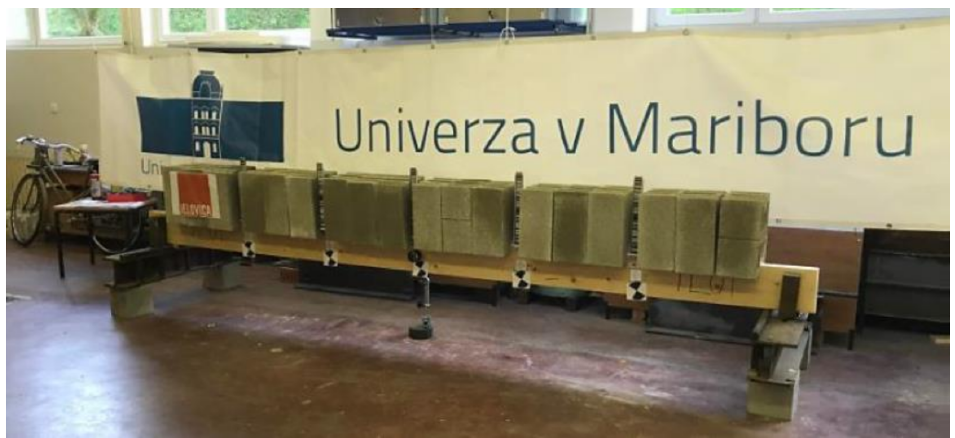
Figure 2. Setting up and loading a timber beam in the laboratory (TL).